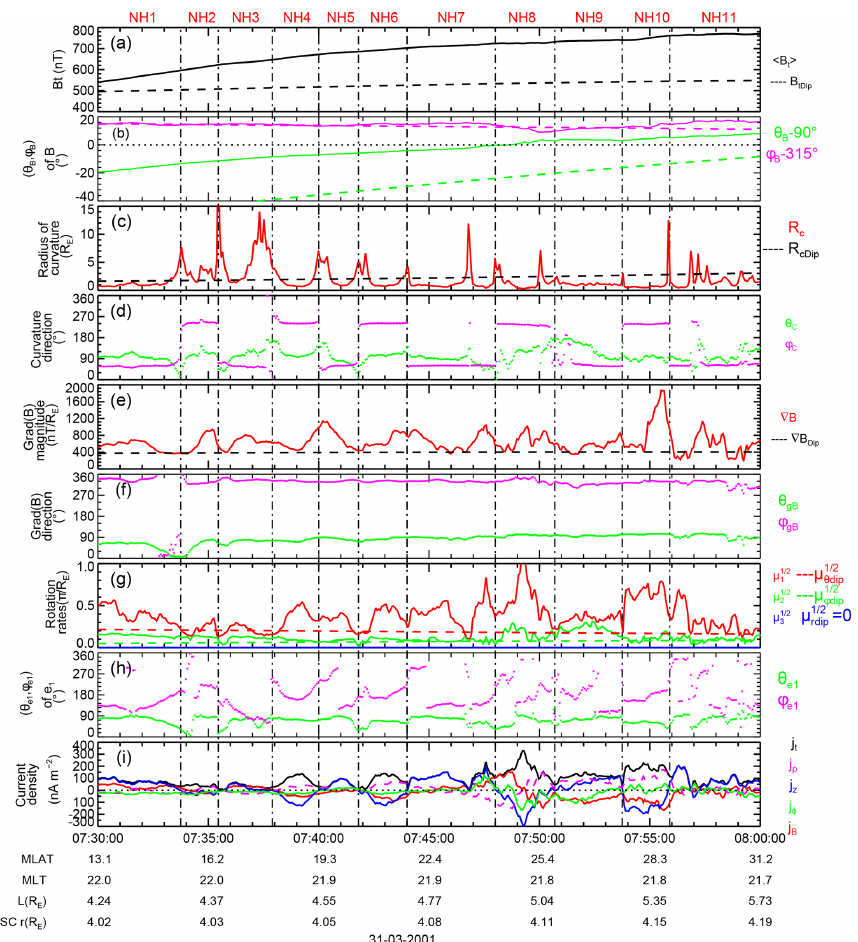
Figure 3. Geometry of the magnetic field and the current distribution in the NH region on 31 March 2001. The format is the same as that of Fig.